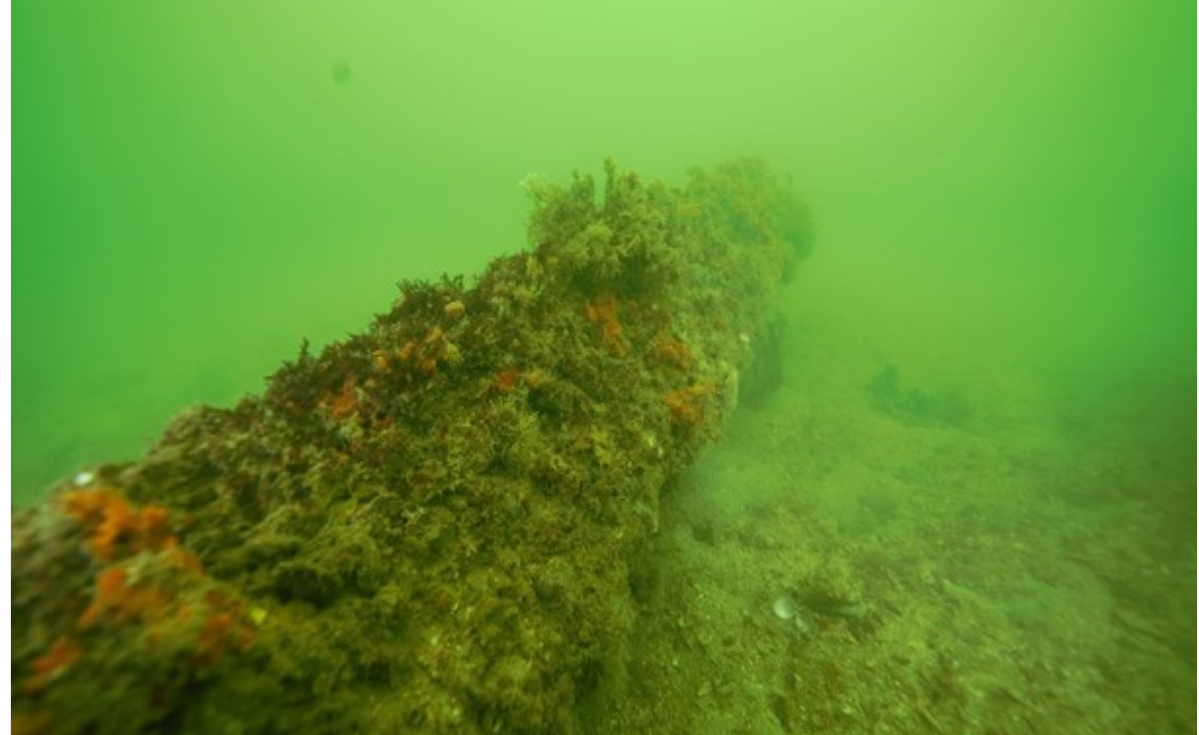
Figure 2. Natural context of the ship, El Conquistador, in the Inner Bay in Cartagena Bay. In the image, a wooden piece of the shipwreck is observed.